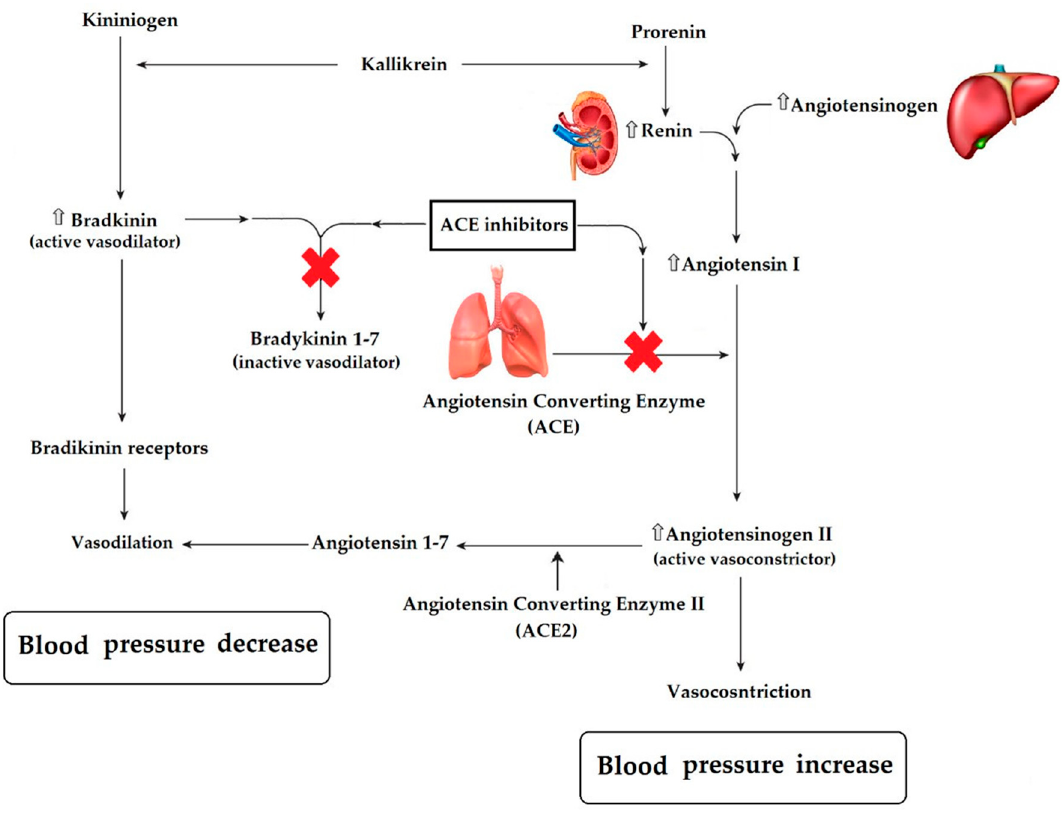
Figure 2. General e ff ects on blood pressure regulation by Angiotensin-Converting Enzyme Figure 2. General effects on blood pressure regulation by Angiotensin-Converting Enzyme (ACE) (ACE) Inhibitors.